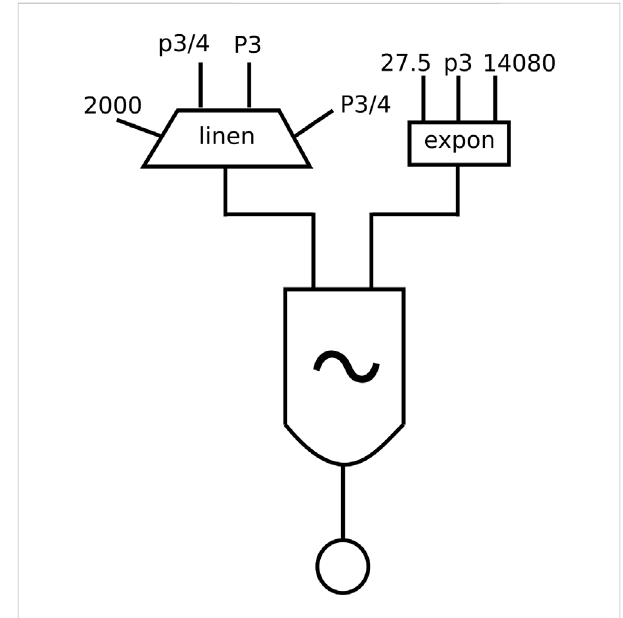
FIGURE 6 For Ann instrument fl